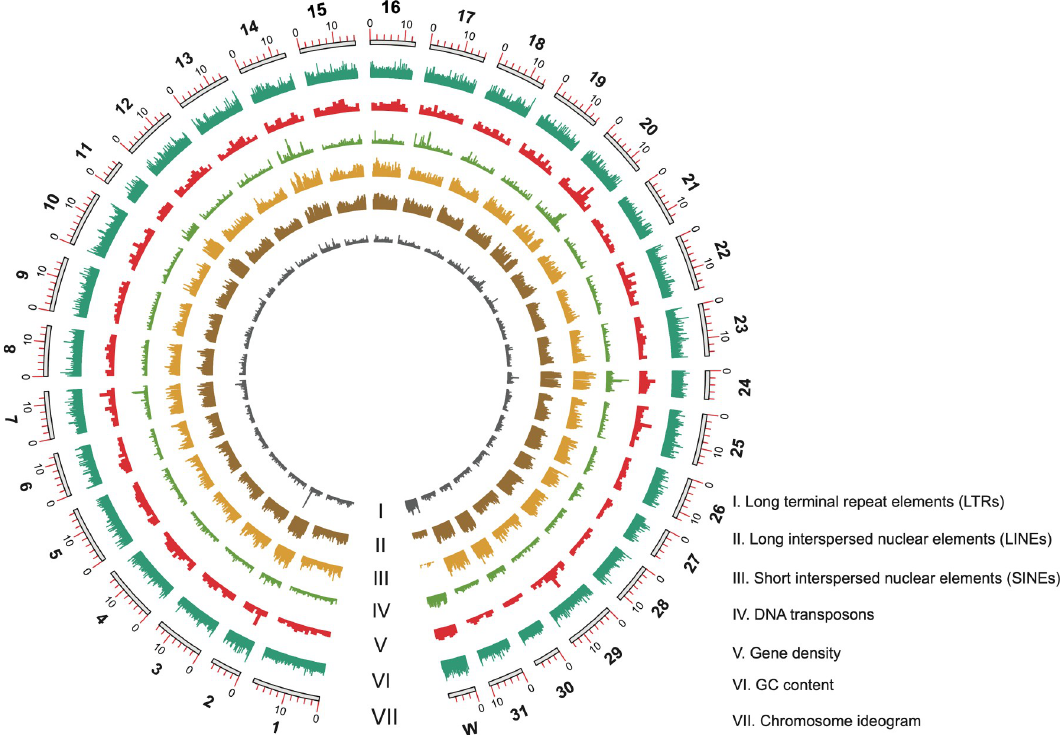
Fig 1. Circos plot of beet armyworm genome. Tracks from innermost to outermost are: I. Long terminal repeat elements (LTRs), II. Long interspersed nuclear elements (LINEs), III. Short interspersed nuclear elements (SINEs), IV. DNA transposons, V. Gene density, VI. GC content, and VII. Chromosome ideogram with numbers indicating the chromosome nomenclature order and size (in Mb). A 10 kb sliding window is shown for the GC content track and 100 kb for all other tracks.